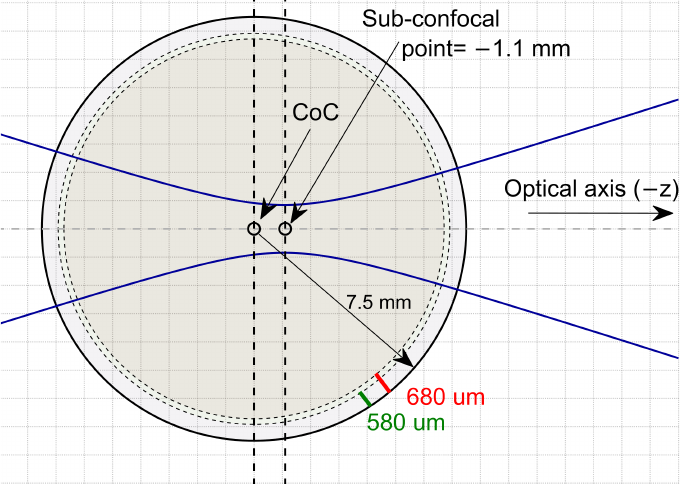
Figure 1. The cornea is illuminated by a Gaussian beam in a way that the beam focus on the sub- confocal point. The cornea radius is 7.5 mm. Corneal phantom thickness is either 580 µ m or 680 µ m discretized to 29 and 34 equally distanced 20 µ m layers, respectively.